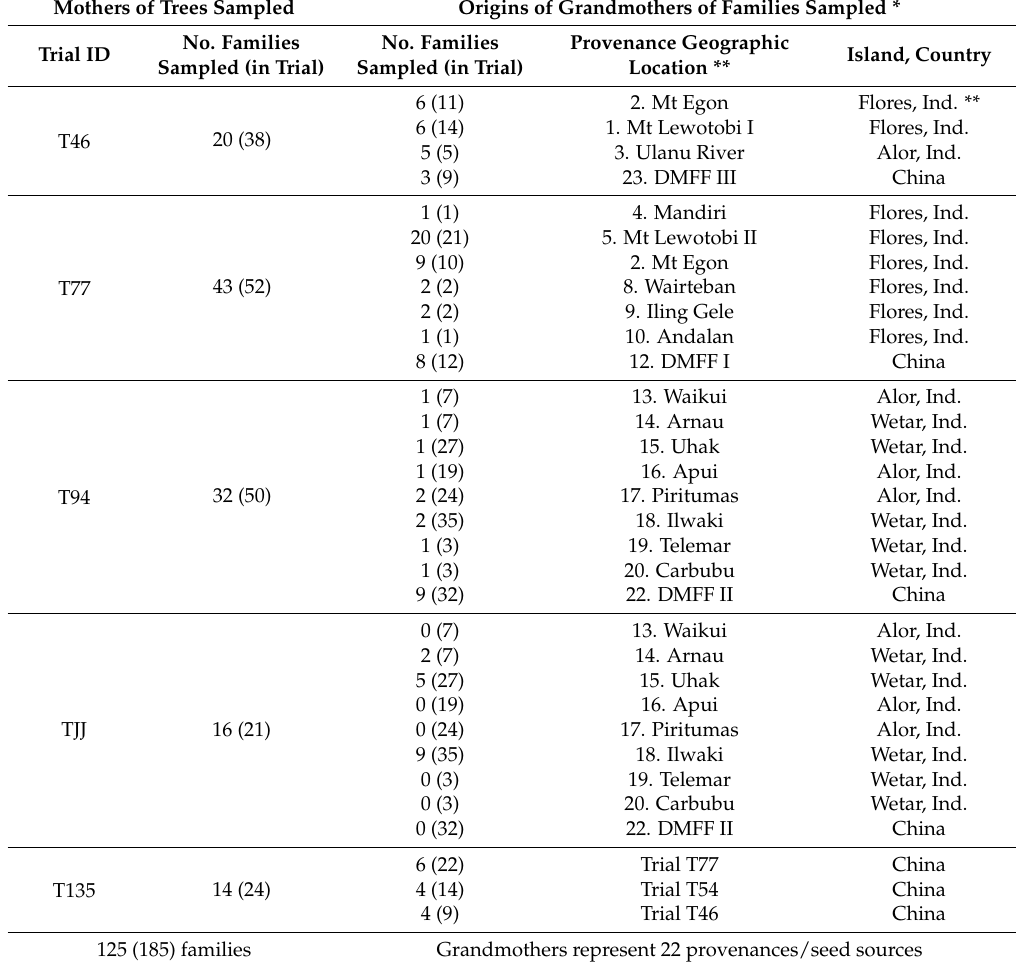
Table 2. Details of the samples obtained from one of the field trials (T164), planted in 2010, of the third cycle breeding population of E. urophylla